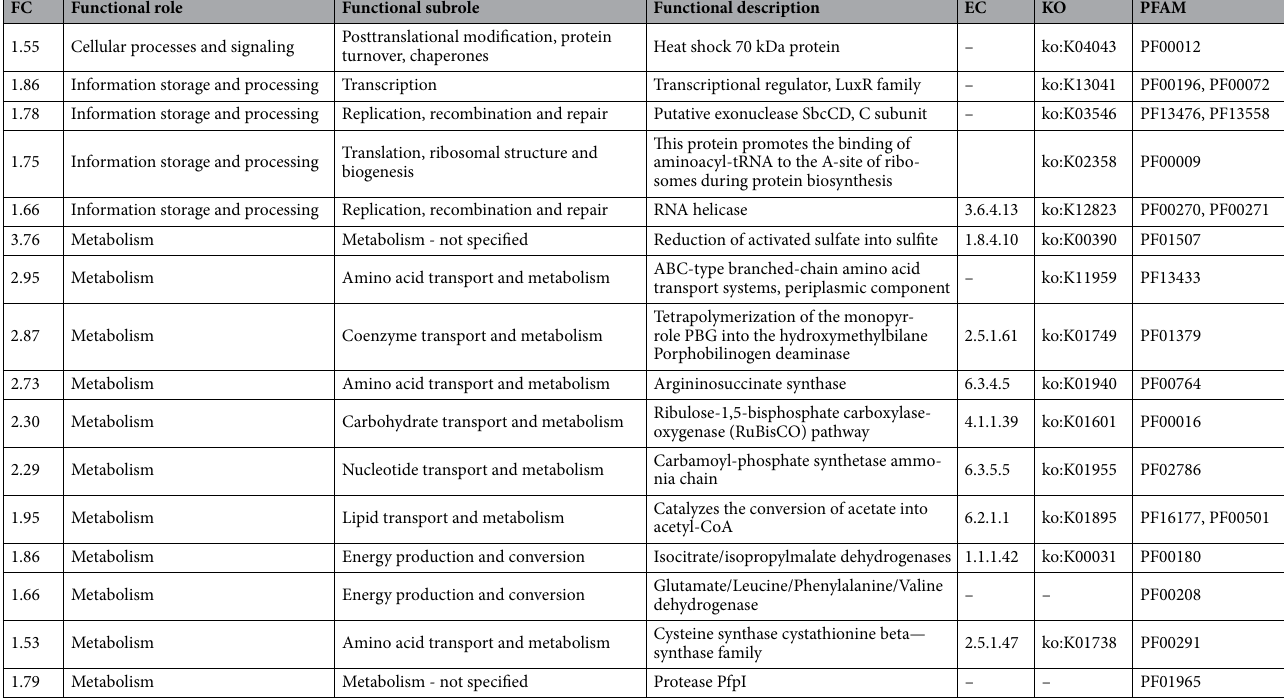
Table 2. List of most abundant (> 0.1%) bacterial protein groups (PGs) with fold changes (FC) > 1.5 with functional annotations, KEGG EC- and KO-numbers and Pfam accession